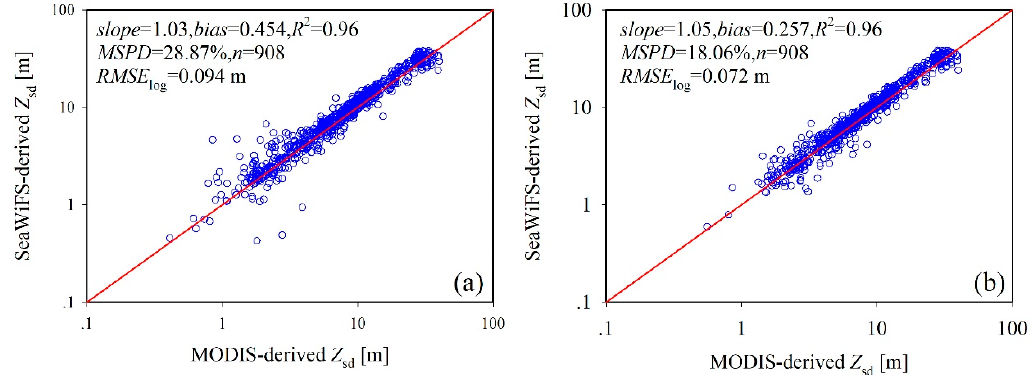
Figure 6. Performance of QAA-based CSSD evaluated using the ( a ) test dataset and ( b ) synthetic dataset in the test 1. As the Hydrolight could not provide the Z sd data, the MSPD and RMSE log values of QAA-based CSSD model in Figure 6b were calculated by comparison of Z sd derived from error-included versus error-free R rs data.